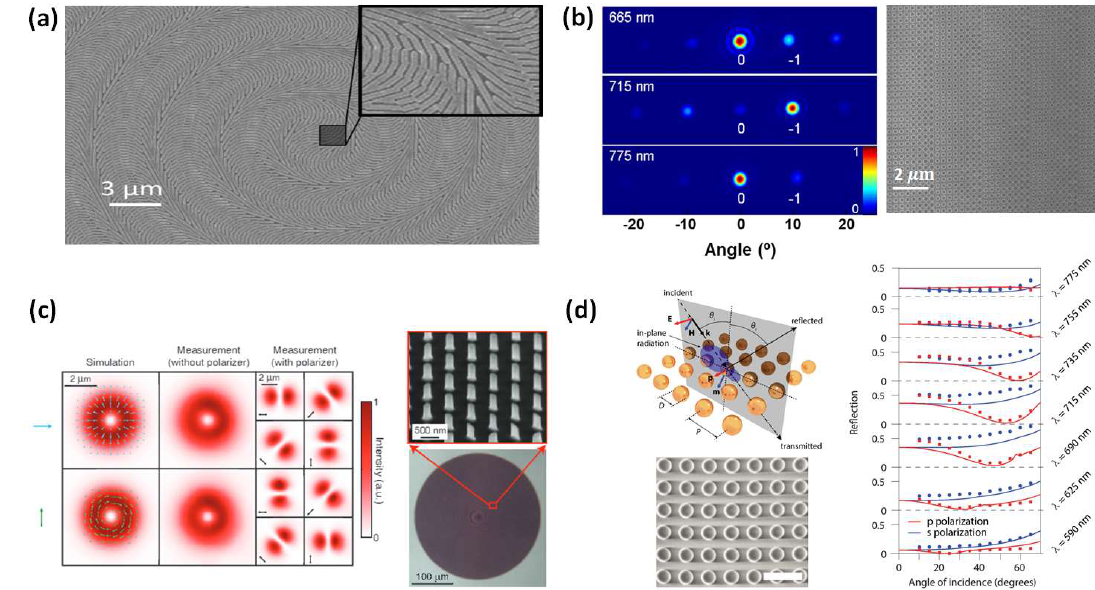
Figure 5: (a) From [28]: SEM image of an axicon lens constructed from silicon nanorods based on nanorod resonances and Pancharatnam- Berry phase concept. (b) From [118]: Huygens gradient metasurface for beam deflection constructed from silicon nanodisks with interfering electric and magnetic dipoles. Right: SEM image; left: back focal plane image of transmitted beam, demonstrating deflection of beam at 715 nm. (c) From [121]: Dielectric metasurface comprised of elliptical cylindrical posts, demonstrating complex polarization and phase con- trol. Radially and azimuthally polarized light beams are simultaneously generated and focused, from incident x (blue arrow) and y (green arrow) polarized light respectively. Right: SEM and optical image of the device; left: simulations and experimental measurements of the generated beams. (d) From [126]: Generalized electro-magnetic Brewster effect demonstrated at a metasurface constructed of resonant sili- con nanodisks. Left: (top) schematic of suppression of angular reflection from a sub-diffractive array of nanoparticles with both electric and magnetic dipoles excited, and (bottom) SEM image of the fabricated silicon nanoparticles. Right: experimental (dots) and theoretical (solid lines) demonstration of wavelength-dependent generalized Brewster effect. Scale bar: 500 nm. Reprinted with permissions from Refs [28], [118], [121] and [126] respectively. Copyright 2014 American Association for the Advancement of Science, 2015